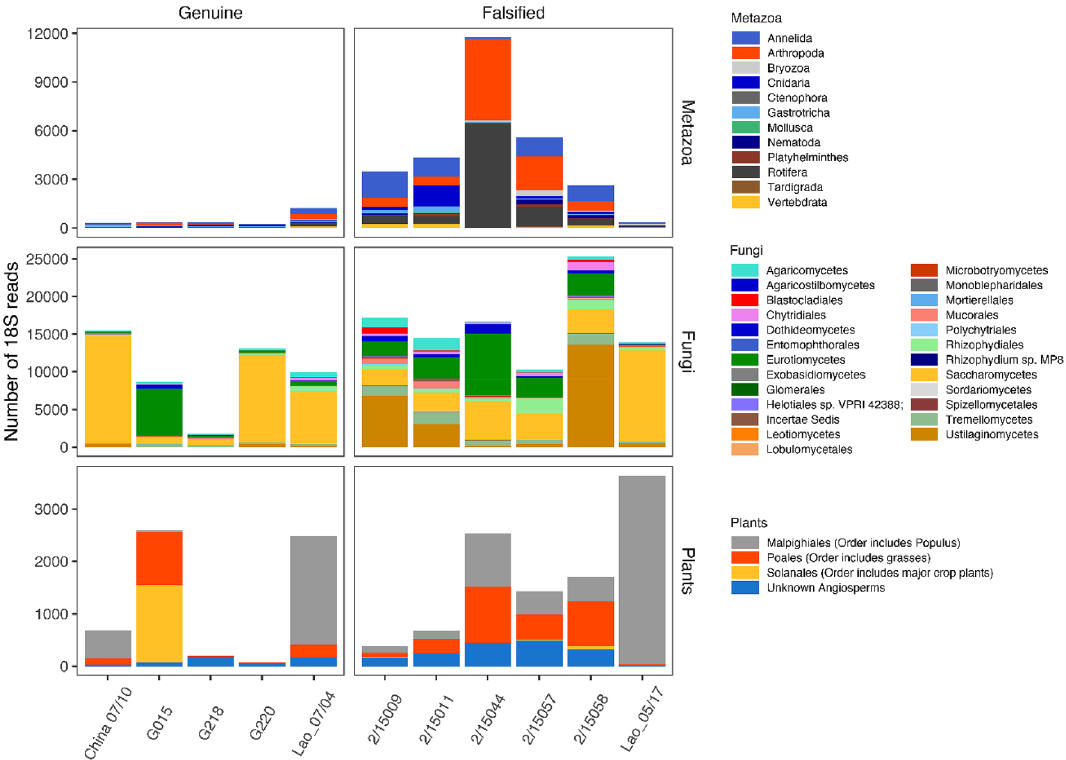
Figure 3. The total number of 18S rRNA sequences assigned to Metazoa (Phylum level), Fungi (Order level) and Plant (Order level) for each genuine and falsified tablet sample. Values represent the total number of sequences detected across all DNA extracts within that sample. * indicates detection of Zea